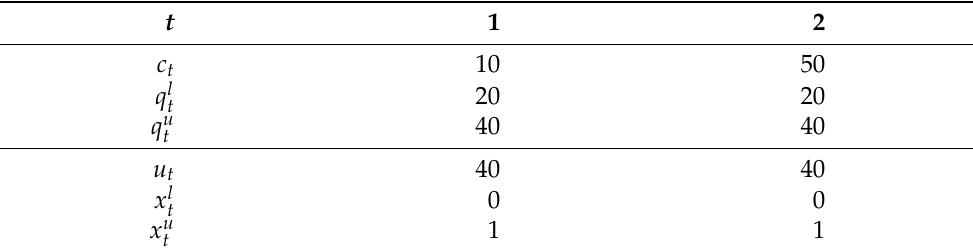
Table 2. Data for Example